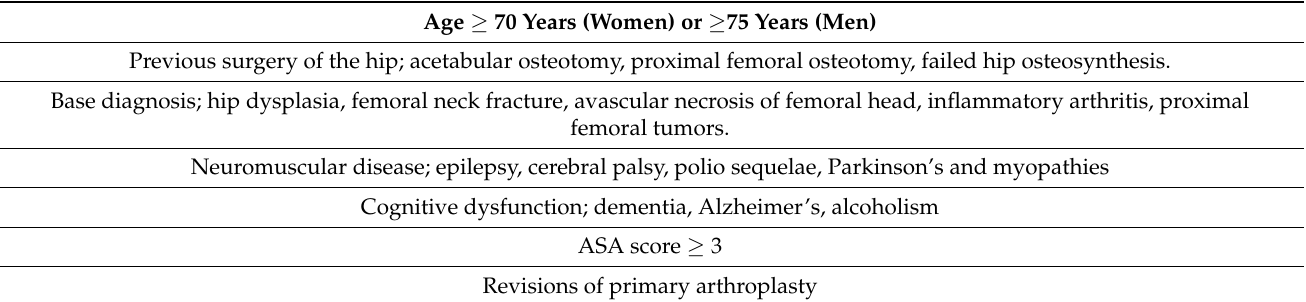
Table 1. Instability risk factors. ASA: American Society of